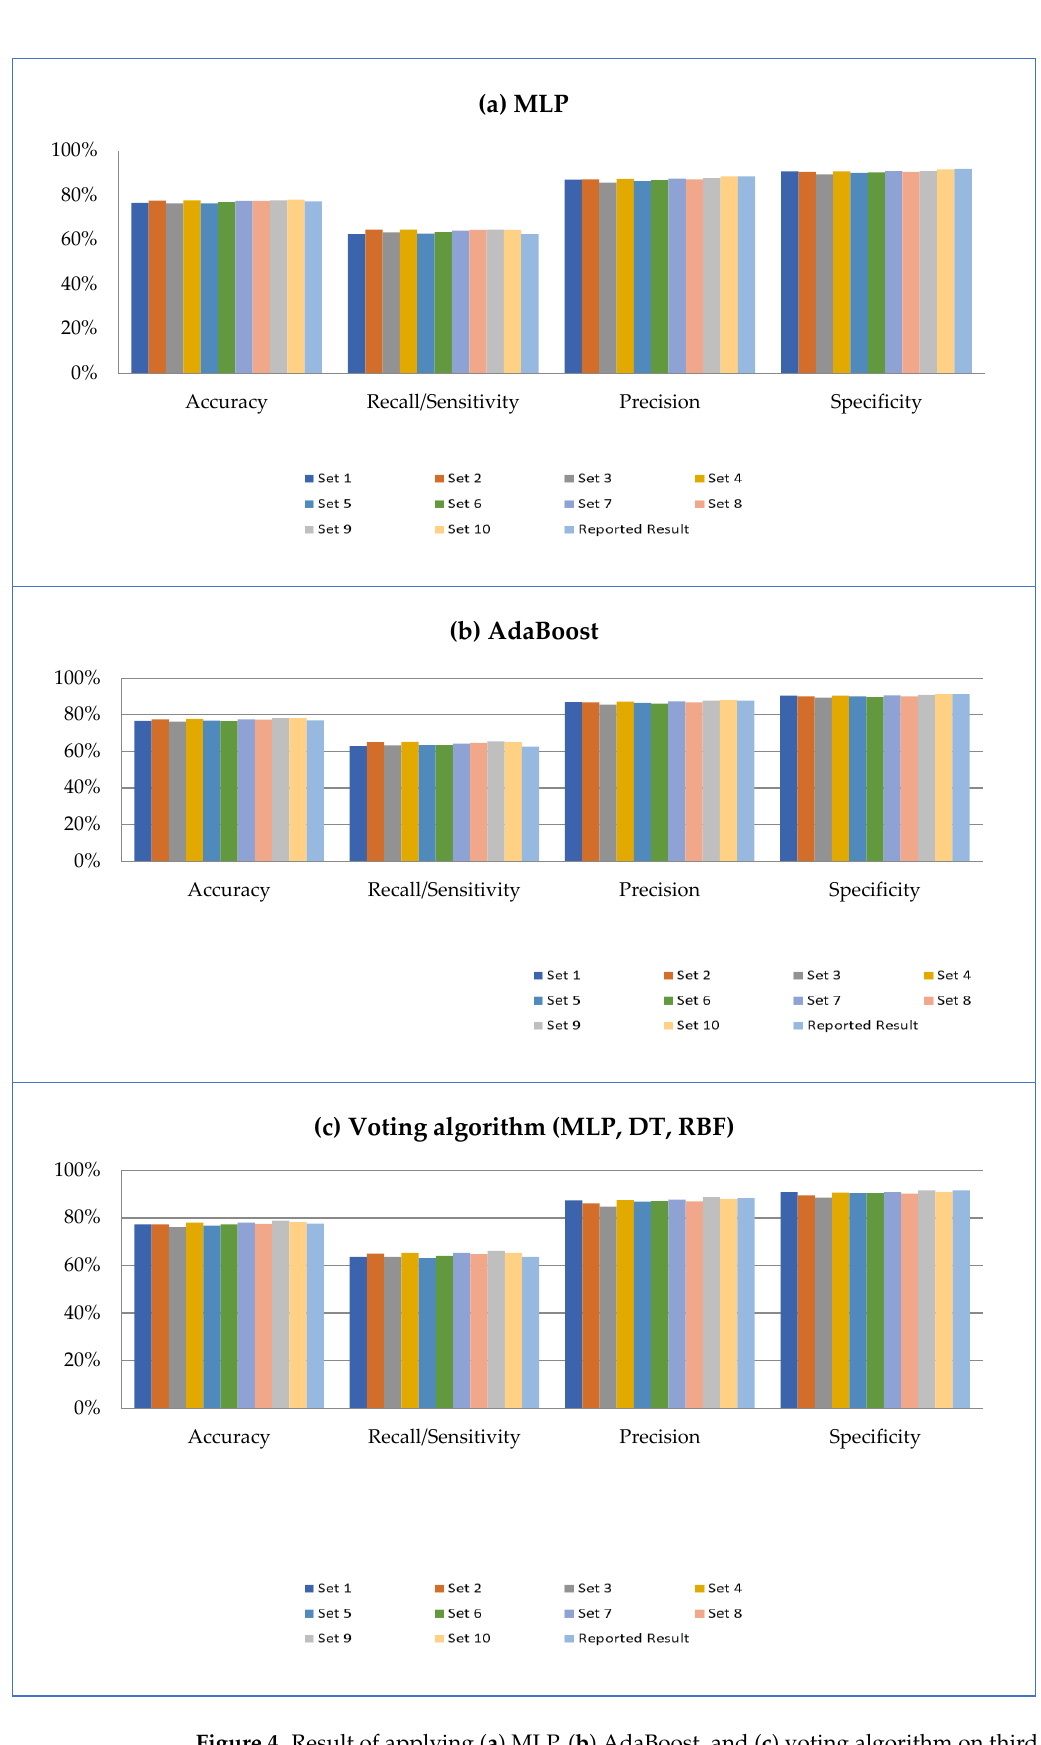
Figure 4. Result of applying ( a ) MLP, ( b ) AdaBoost, and ( c ) voting algorithm on third model.